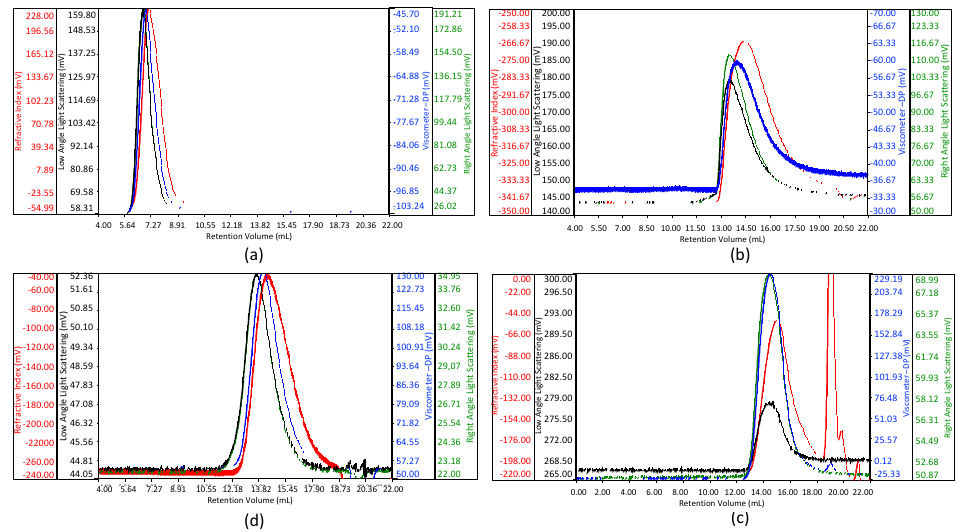
Figure 1. High-performance size exclusion chromatography on line with a triple detector array (HP-SEC-TDA) chromatogram of gelatin ( a ) and gelatin-methylfuran (MF) ( b ) chitosan ( c ) chitosan-MF ( d ) samples (red—refractive index; blue—viscometer; green—right-angle laser light scattering and black—low angle light scattering).